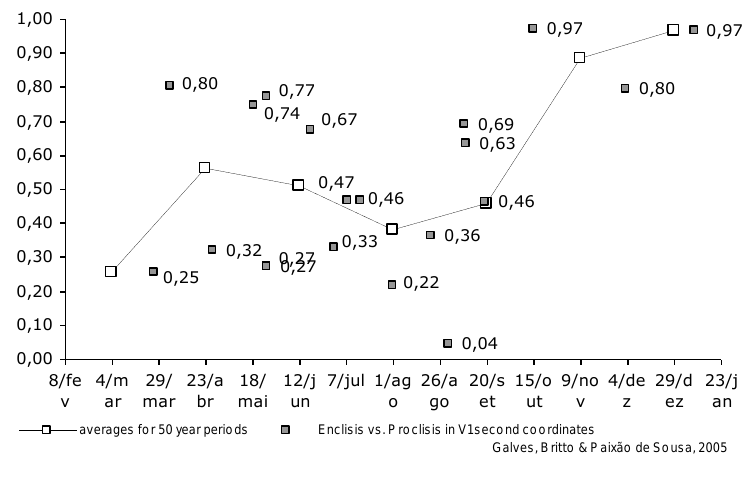
Enclisis vs. Proclisis in V1 second coordinates Galves, Britto & Paixão de Sousa, 2005